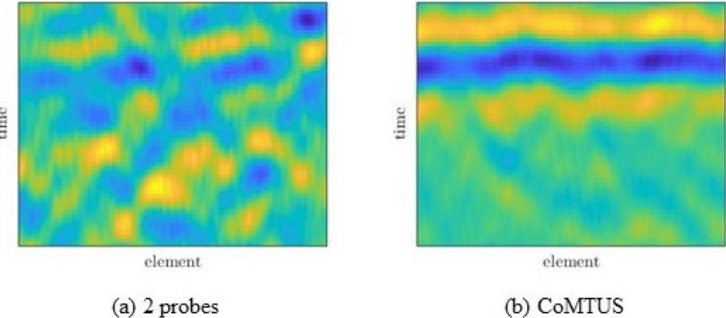
Figure 11. Simulated delayed RF data for a medium with a fat layer of 35 mm in thickness and backscattered from a point-like target, obtained by coherently adding the four delayed backscattered echoes from the same point-like target ( T 1 R 1 , T 1 R 2 , T 2 R 1 , T 2 R 2 ) using different beamforming parameters: ( a ) 2 probes; ( b )